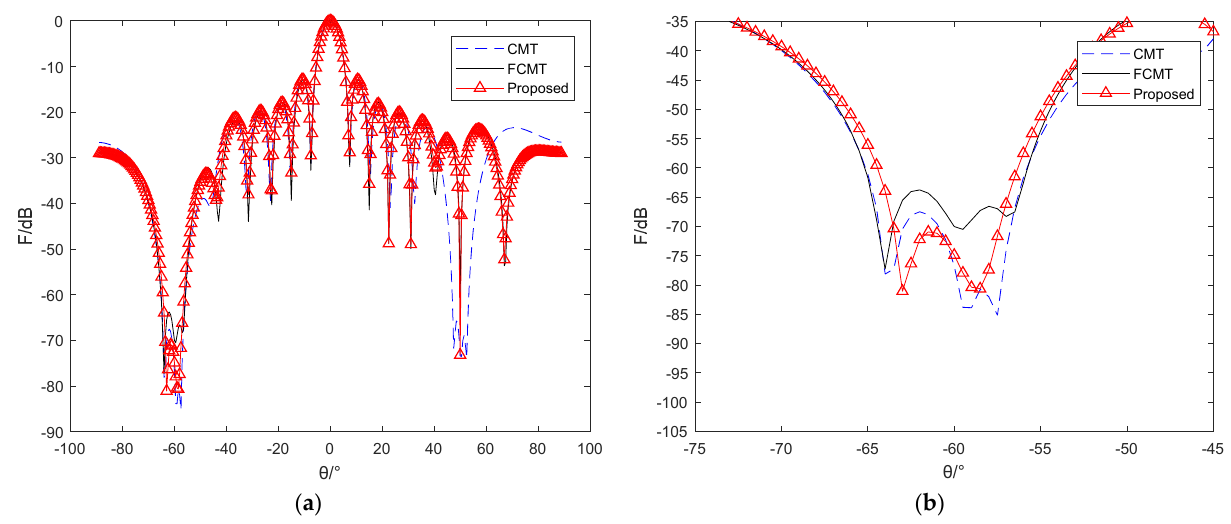
Figure 2. Null broadening pattern: ( a ) overall pattern, ( b ) local enlarged drawing.